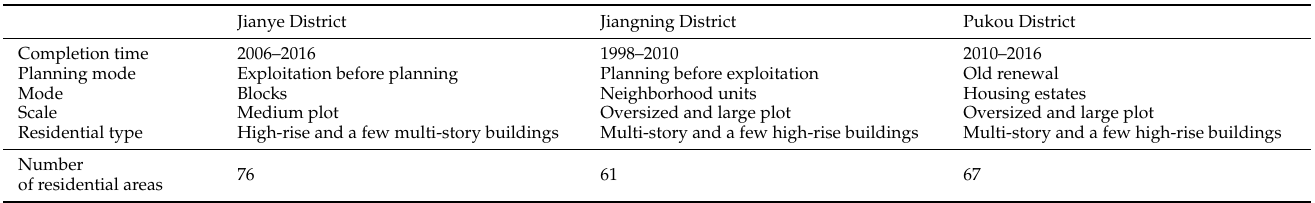
Table 1. Characteristics of 204 residential areas investigated in 3 administrative